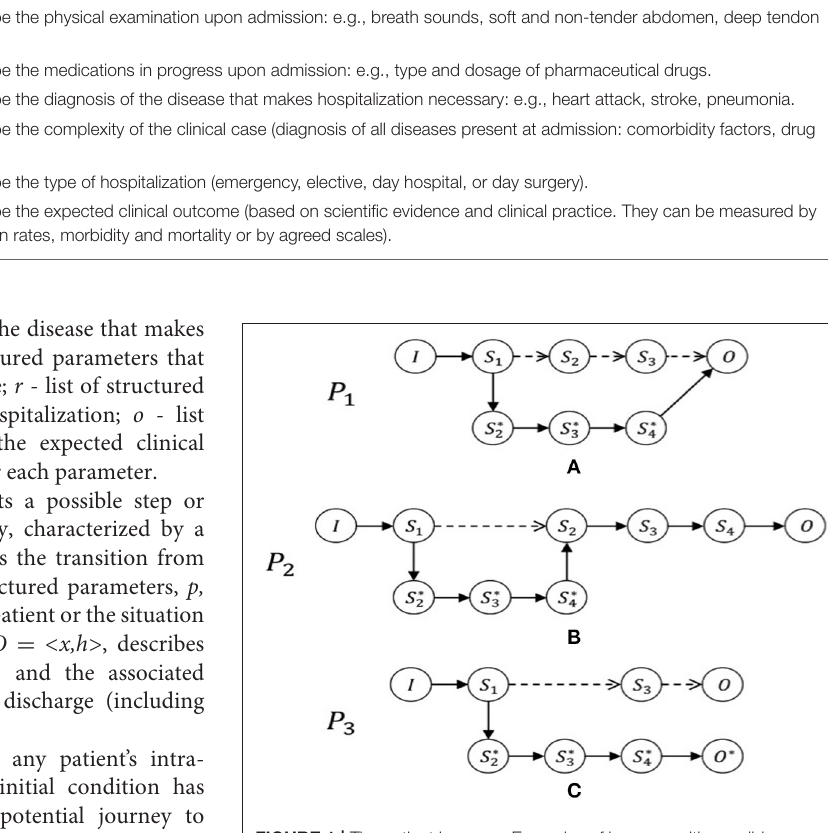
FIGURE 1 | The patient journeys. Examples of journeys with possible variations: In (A) , journey P1 varies from the initial expectations after step S1 . It consequently then becomes the real journey, P1 * and passes through new stages that had not been anticipated and finally arrives at the expected result, O . In contrast, journey P2 , as shown in (B) , is varied by means of an additional stage between Steps S1 and S2 . In the journey P3 , shown in (C) , we see a substantial variation from the expected journey, producing an unintended final condition, O * 6= O. By analyzing the journeys of patients, it is possible to